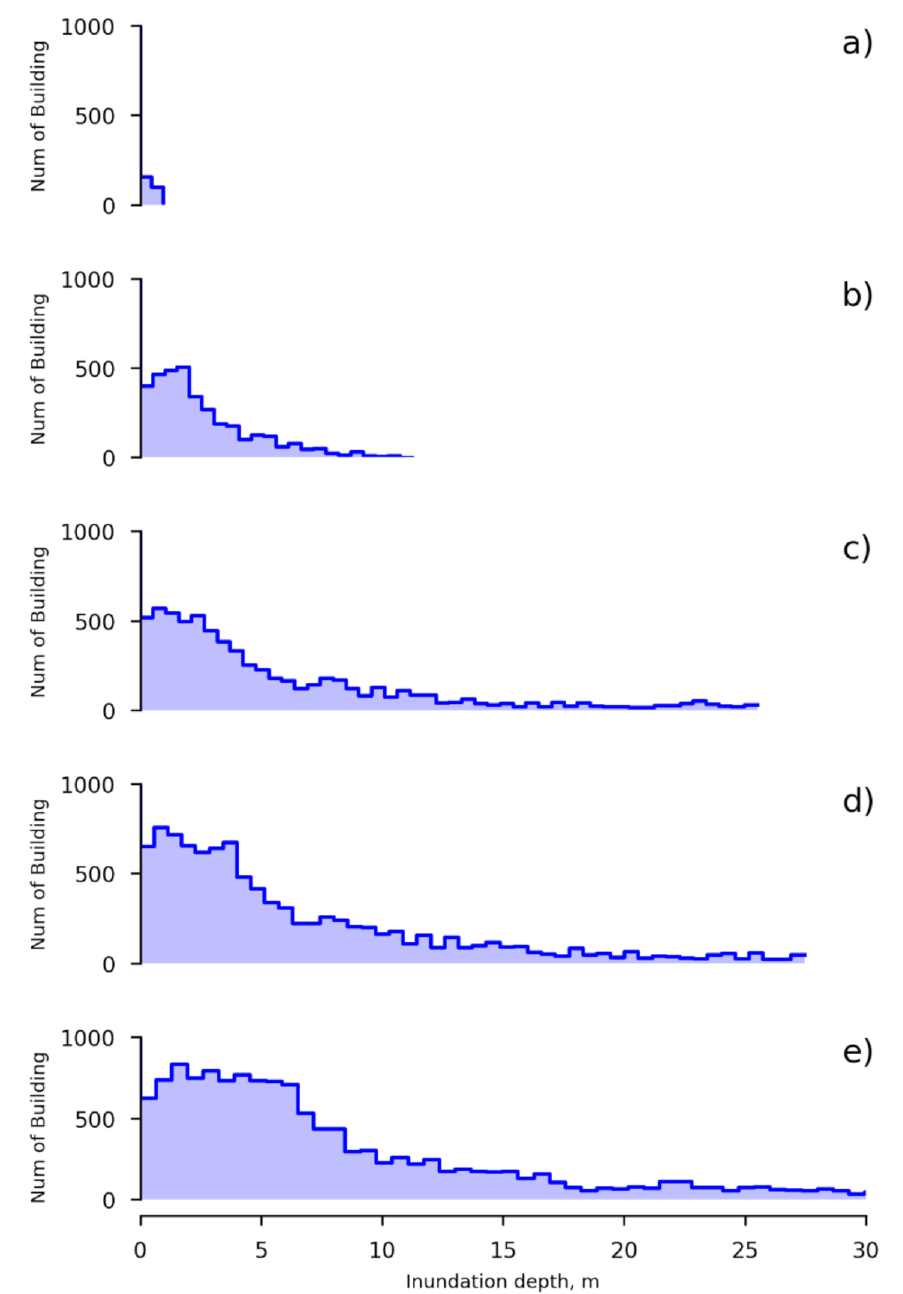
Figure 6. Number of buildings represented in each inundation depth (flow depth at the building point) range to present the hazard characteristics, with examples of ( a ) the 1st scenario, ( b ) 25th sce- nario, ( c ) 50th scenario, ( d ) 75th scenario, and ( e ) 99th